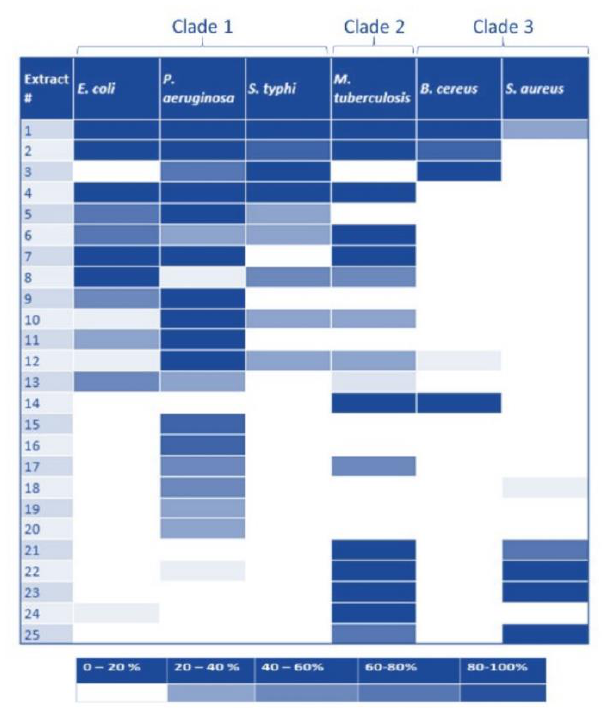
Figure 6. Natural Product Inhibition of Pth1 Spanning Phylogenetic Space. Inhibitory activity for a panel of natural product extracts tested for inhibition against Pth1 is shown. The degree of inhibition is shown at the bottom, with darker color indicating stronger inhibition.